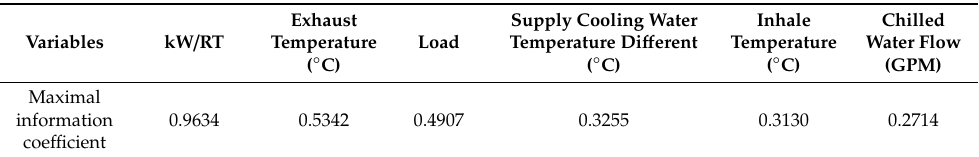
Table 3. Maximal information coe ffi cient of performance (COP).